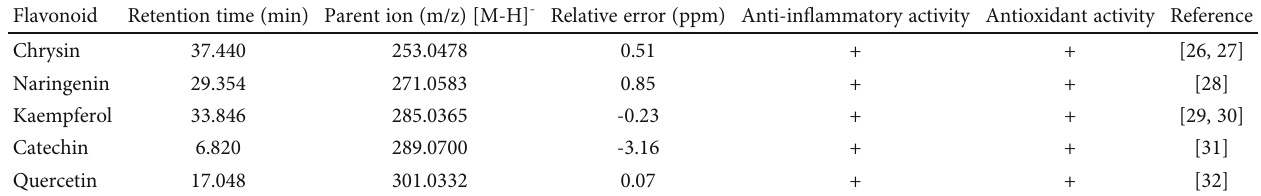
Table 2: Flavonoids identi fi ed as part of the chemical composition of the C. procera methanolic extract.